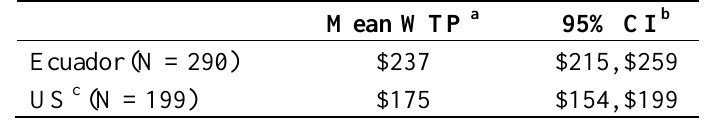
Table 4. Estimated Mean WTP and 95% CI for Reducing the Risk of CM Mortality by 1 in 100,000: Ecuador and the United